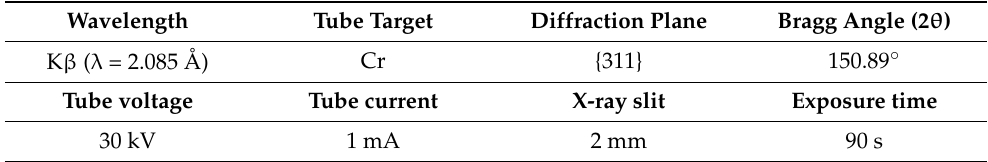
Table 2. X-ray diffraction parameters used for residual stress